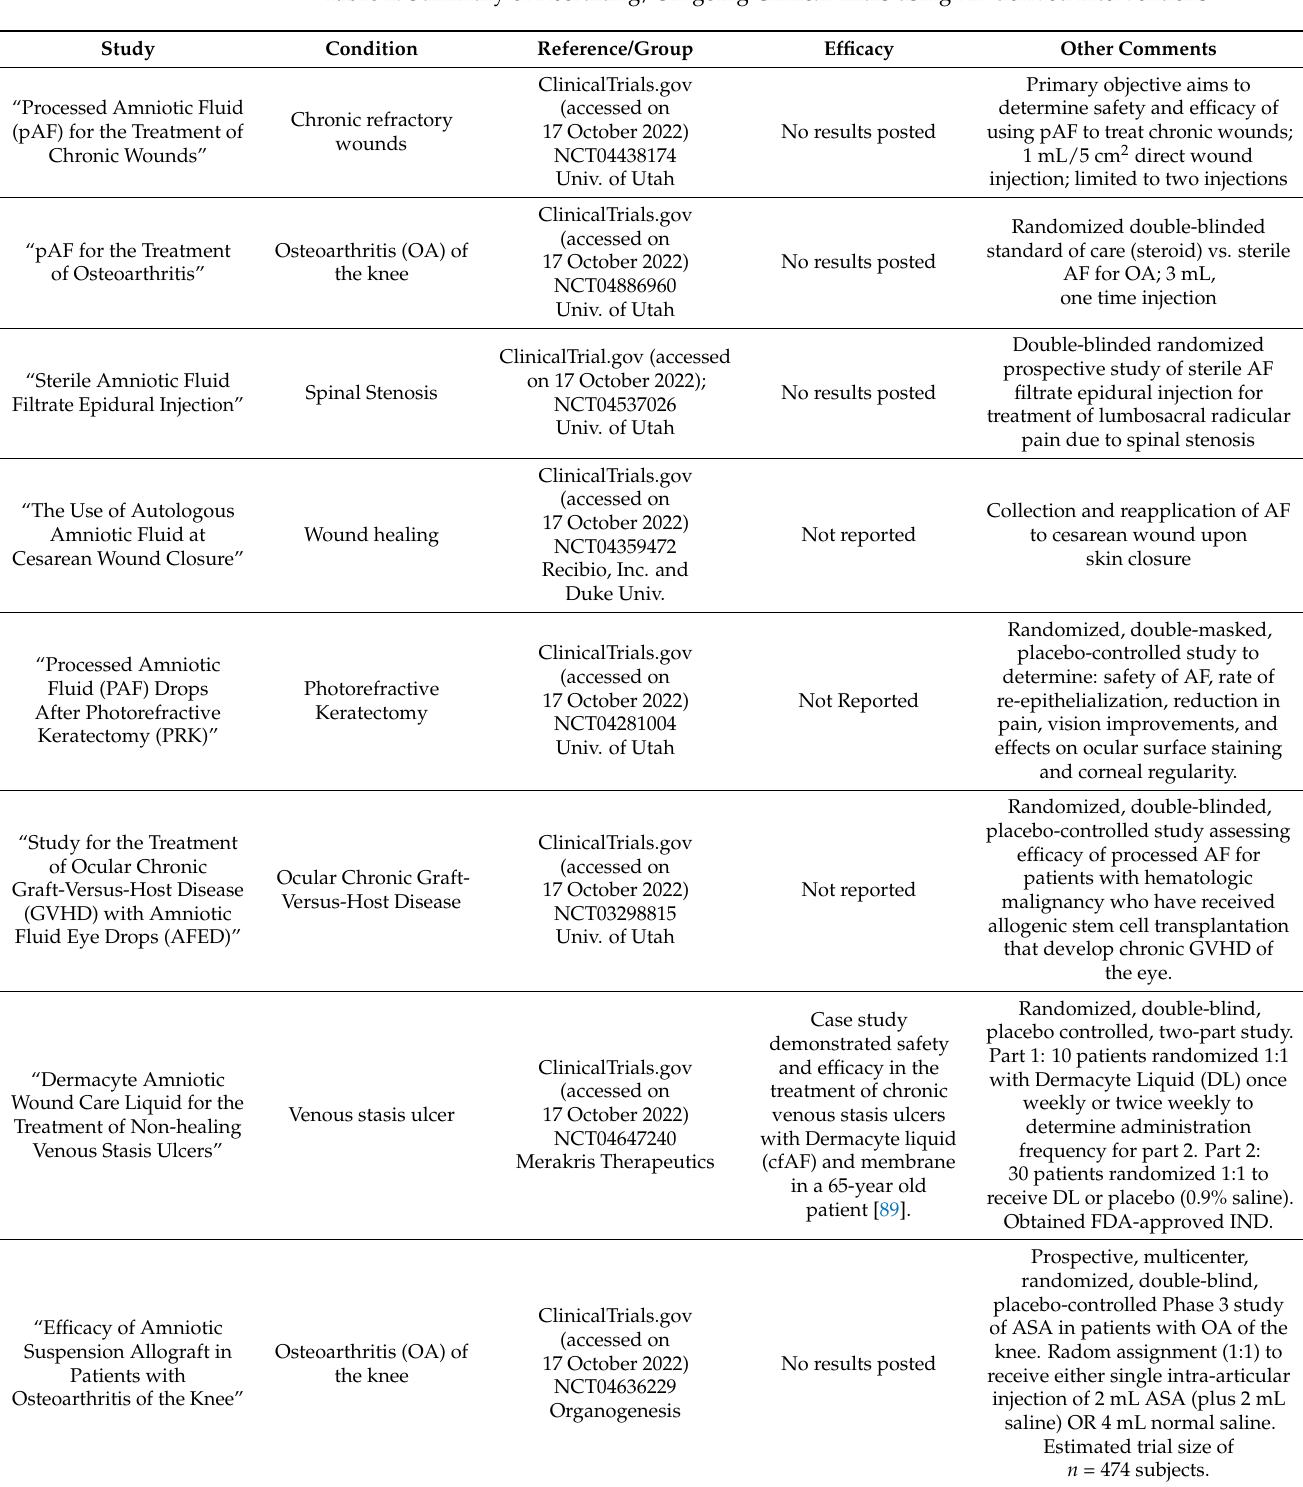
Table 2. Summary of Recruiting/On-going Clinical Trials using AF-derived